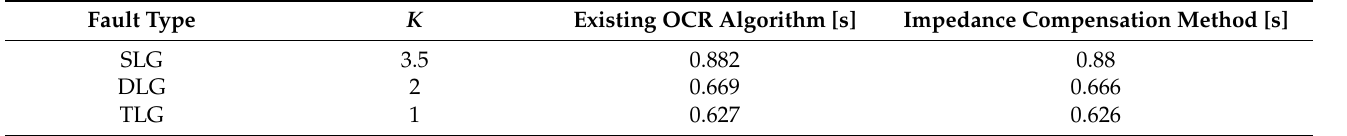
Table 4. Simulation result by fault type.